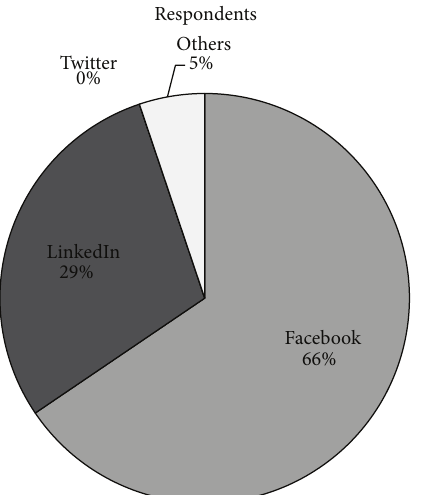
Figure 1: Survey respondent by SNS.